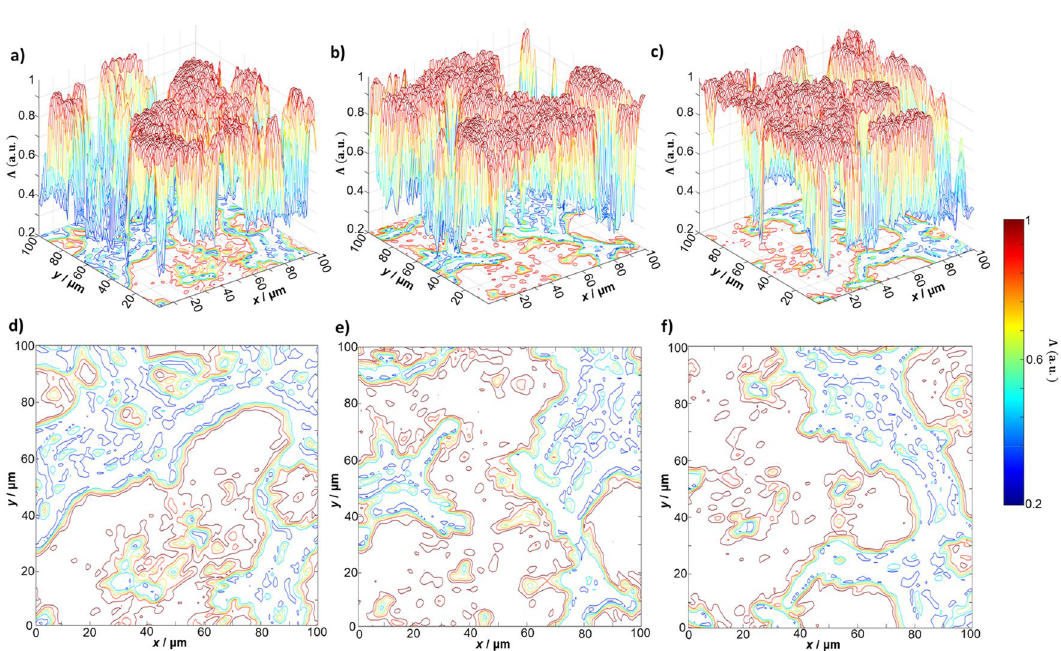
Figure 4. The layered distribution of the degree of depolarisation of a histological section of parenchymal liver tissue. The distribution is shown as ( a – c ) 3D surfaces and ( d – f ) 2D contours, for the phase sections at ( a , d ) θ k = 0.3 rad , ( b , e ) θ k = 0.9 rad , and ( c , f ) θ k = 1.5 rad respectively. Data visualised using the meshc and contour plot functions in Matlab R2020a (www.mathw